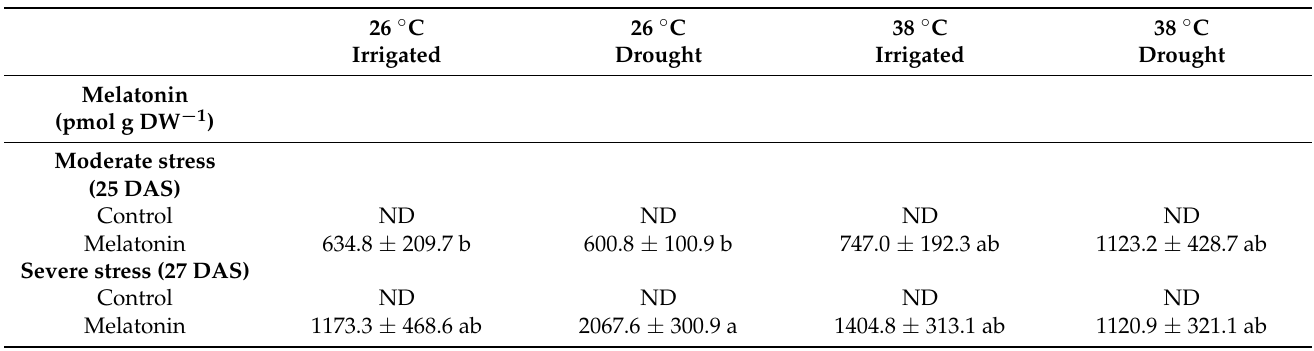
Table 1. LC–MS analysis of melatonin performed on leaf material harvested during moderate stress (drought-stressed at SRWC ~50% and heat stress for 1 day) and severe stress (drought-stressed at SRWC ~20% and heat stress for 3 days). Values are mean ± SE. Letters indicates differences between stress treatment groups across the two stress levels. ND, not